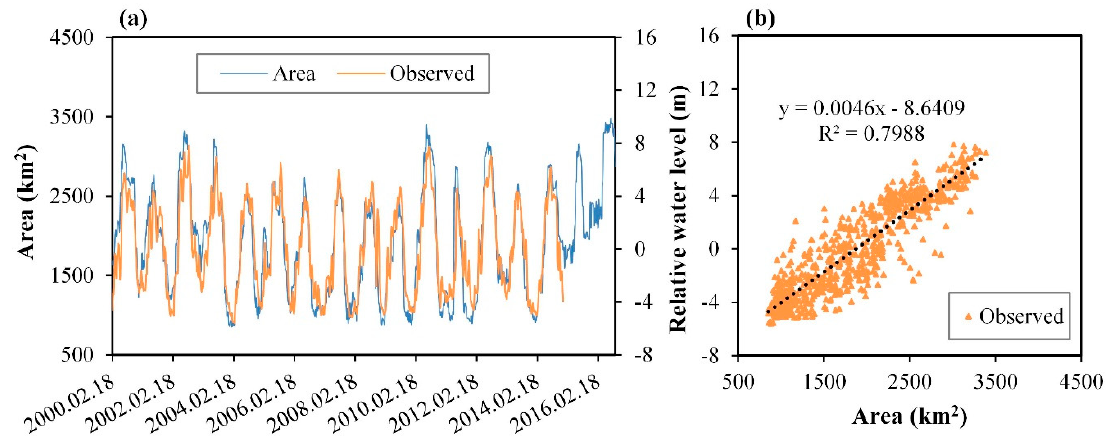
Figure 13. The relationship between the water area and water level. ( a ) Time series of the water area and observed relative water level in 2000–2016. ( b ) The correlation between them.